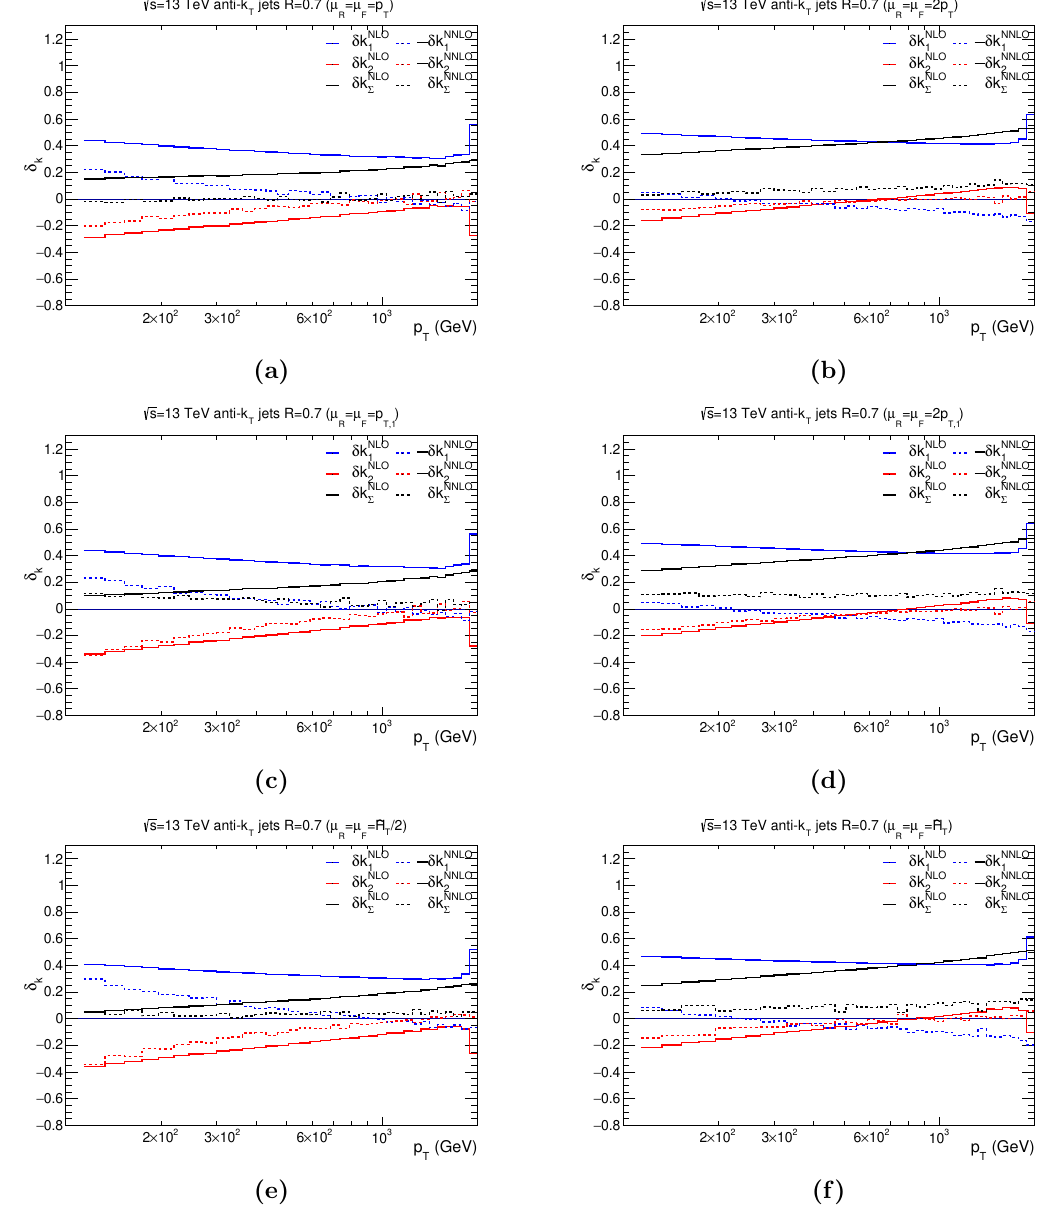
p Figure 12 . Di(cid:11)erential correction factors at s = 13 TeV for the leading jet ( (cid:14)k N k LO , blue), 1 subleading jet ( (cid:14)k N k LO , red) and the inclusive jet distribution ( (cid:14)k N k LO , black) with R = 0 : 7 and 2 (cid:6) integrated over rapidity for the scale choices (a) (cid:22) = p T , (b) (cid:22) = 2 p T , (c) (cid:22) = p T ; 1 , (d) (cid:22) = 2 p T ; 1 , (e) (cid:22) = ^ H T = 2, (f) (cid:22) = ^ H T